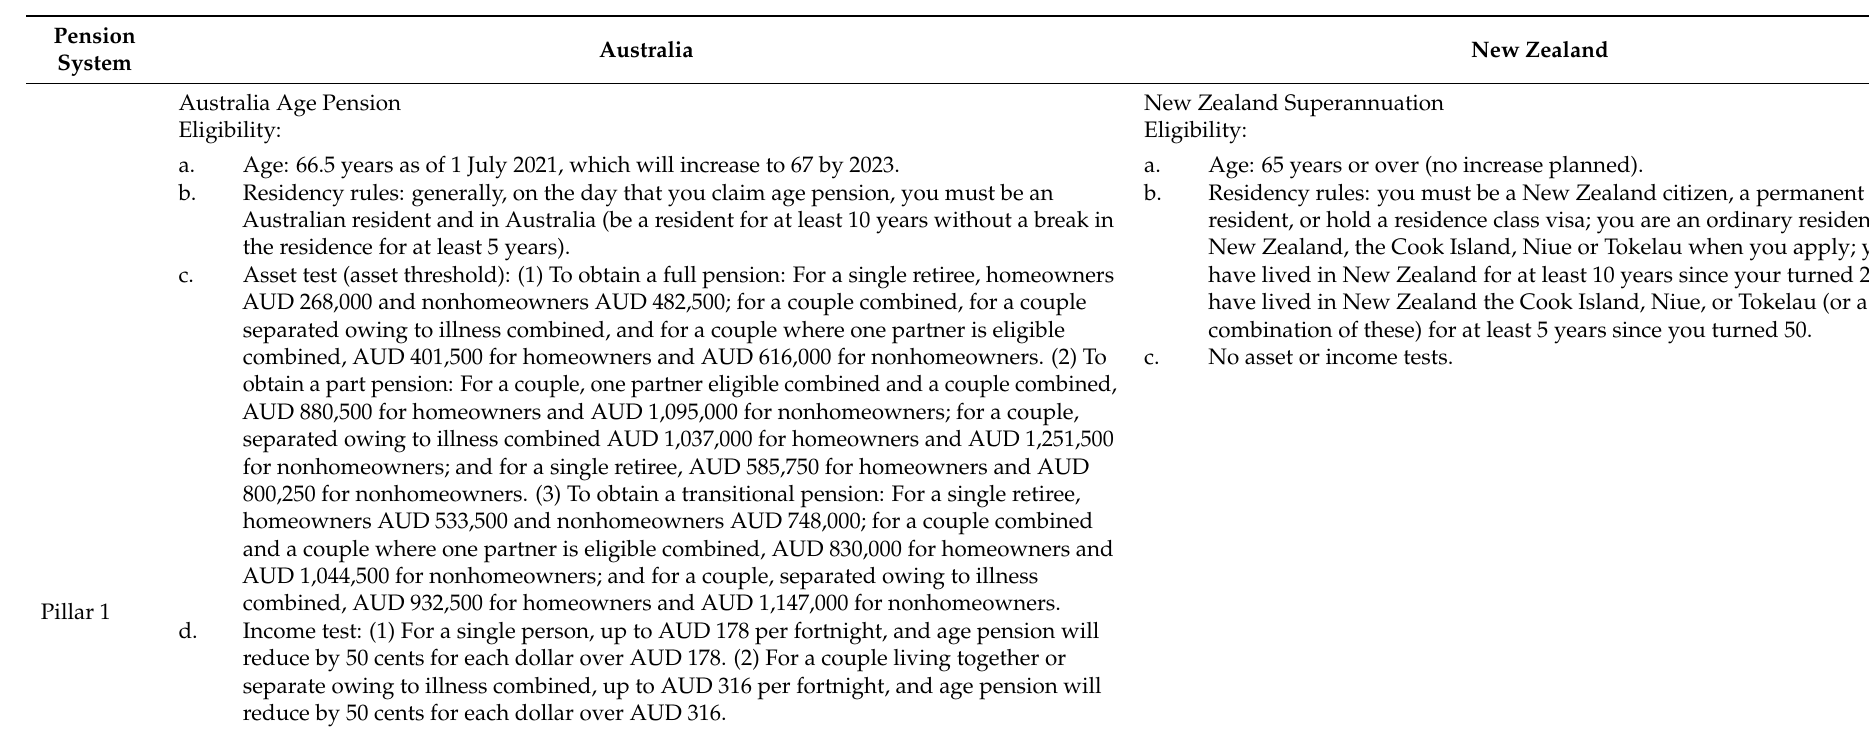
Table A1. Australia and New Zealand Pension